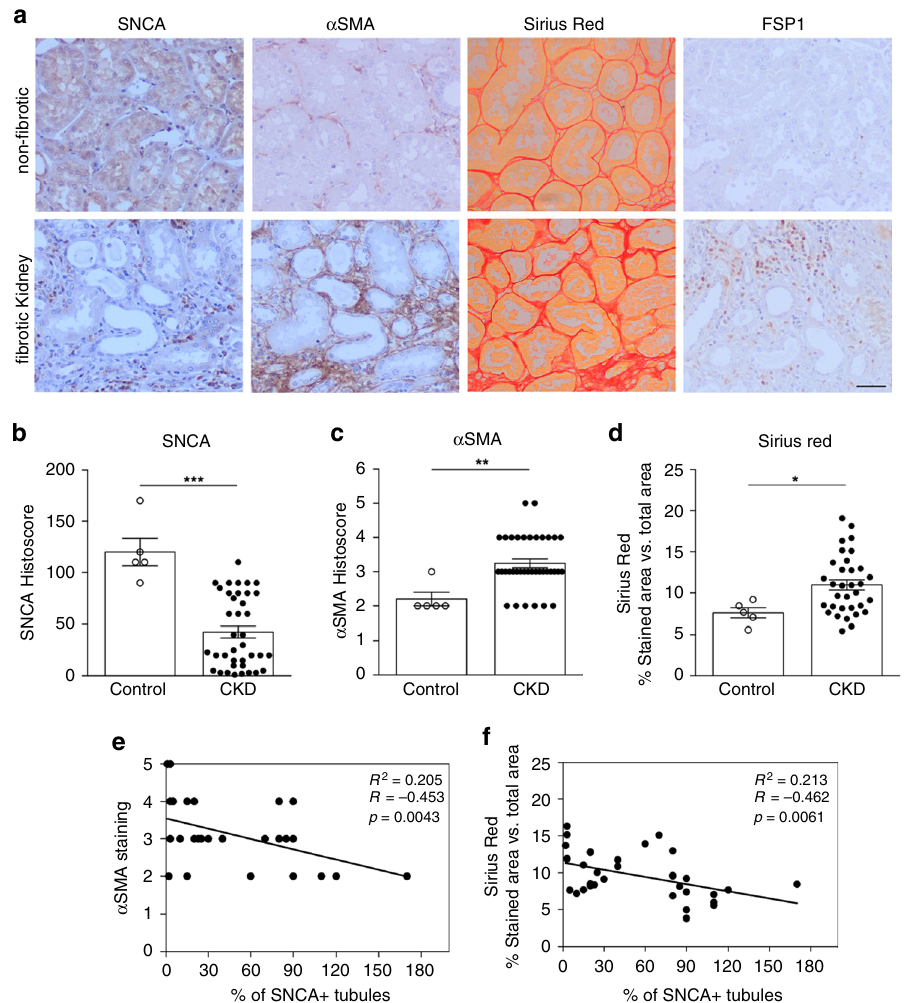
Fig. 5 Decreased SNCA expression in human fi brotic kidney samples. a Representative images of immunoperoxidase staining for SNCA, α -SMA, FSP1, and Sirius Red staining in human kidney sections. Scale bar represents 50 µ m. b , c Quanti fi cation of SNCA staining in tubular cells ( b ) and α -SMA immunostaining ( c ) in kidney sections of patients with proven tubulointerstitial fi brosis versus kidney sections with no evidence of fi brosis. Data are presented as mean ± SEM ( n = 5, healthy tissue; n = 38, fi brotic tissue). d Quanti fi cation of collagen content after Sirius red staining was shown as a positive stained area vs. total analyzed area. Data are presented as mean ± SEM ( n = 5, healthy tissue; n = 38, fi brotic tissue). e , f Scatter plots with linear regression show correlation analysis between the percentage of SNCA positive tubules and e the degree of α -SMA staining and/or f the extent of renal fi brosis evaluated by Sirius red staining. Linear regression shows an inverse correlation between the percentage of SNCA positive tubules and the degree of α -SMA staining ( e ), as well as the fi brosis score ( f ). The Spearman correlation coef fi cient ( R ) and p value are shown. * p < 0.05, ** p < 0.005, *** p < 0.001 vs. control healthy kidney tissue. The p-value by two-tailed Student's t -test. Source data are provided as a Source Data fi